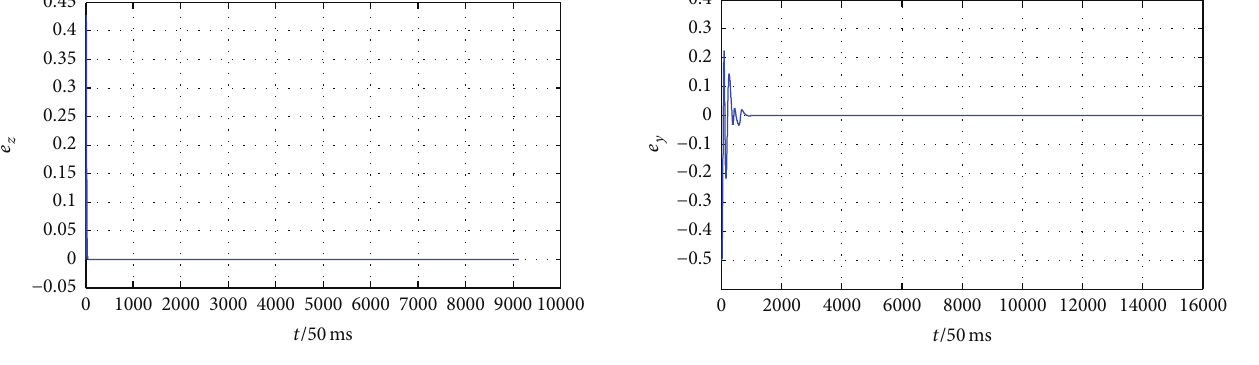
Figure 13: The curve 𝑒 𝑦 for single variable feedback